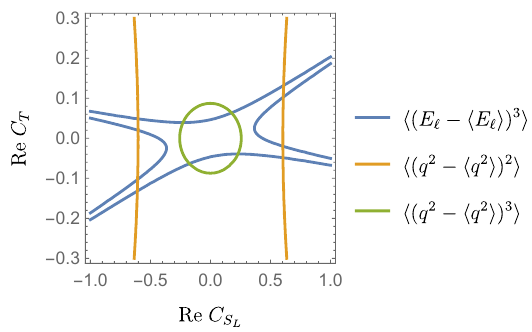
and C from lepton energy T L